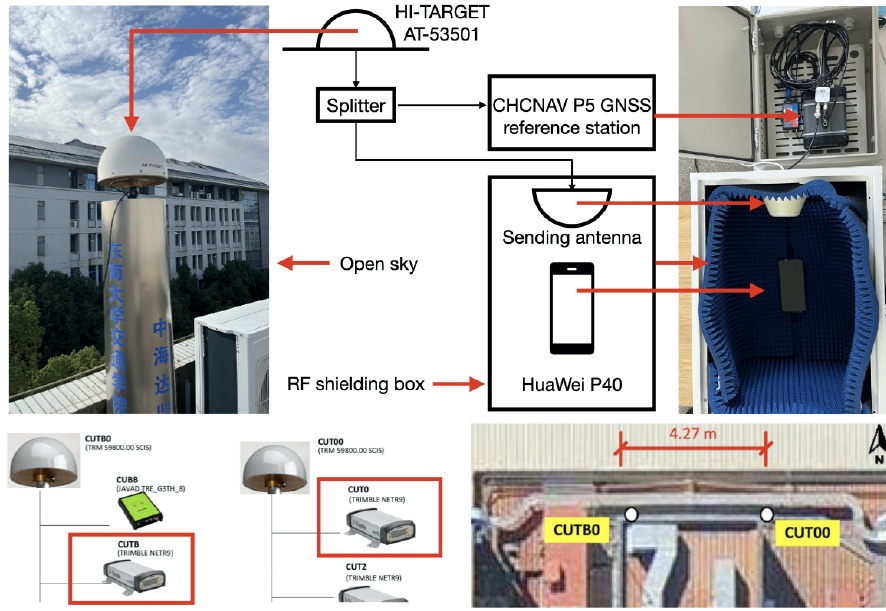
Figure 1. Layout of the smartphone and receiver for two static baselines.